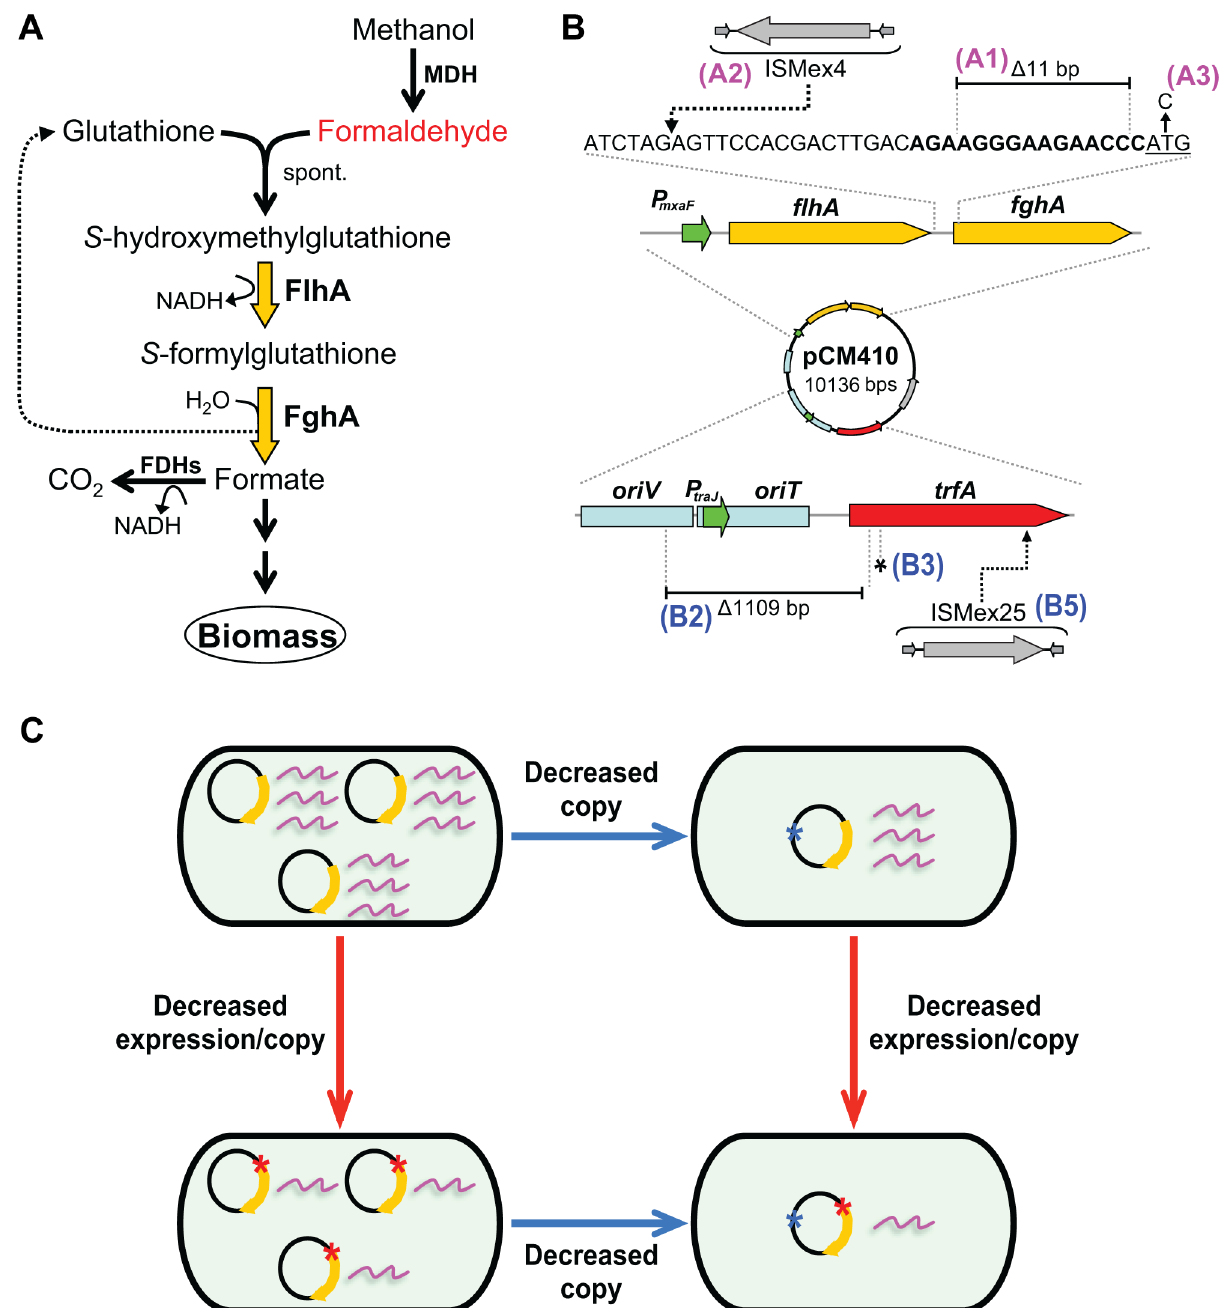
Figure 1. Adaptive mutations that optimized the expression of the GSH-linked pathway. A) The GSH-linked formaldehyde oxidation pathway in the EM strain. The enzymes of the GSH-linked pathway are indicated with yellow arrows. MDH, methanol dehydrogenase; spont., spontaneous reaction of formaldehyde and GSH; FlhA, S -hydroxymethyl GSH dehydrogenase; FghA, S -formyl-GSH hydrolase; FDHs, formate dehydrogenases. B) Adaptive mutations identified on the introduced plasmid (pCM410) expressing the introduced formaldehyde pathway. Mutations occurring in the predicted ribosome-binding site (bold text) of fghA , or its upstream region are shown in magenta (Class A). Mutations occurring in regions that control plasmid replication are shown in blue (Class B). The fghA start codon is underlined. trfA , a gene encoding the TrfA protein essential to plasmid replication; P mxaF , promoter of the flhA - fghA gene cassette; oriV , origin of replication recognized by the TrfA protein; oriT , origin of transfer. ISMex4 and ISMex25, two insertion sequences native to M. extorquens AM1. C) Diagram of orthogonal mechanisms of Class A and B mutations on gene expression.